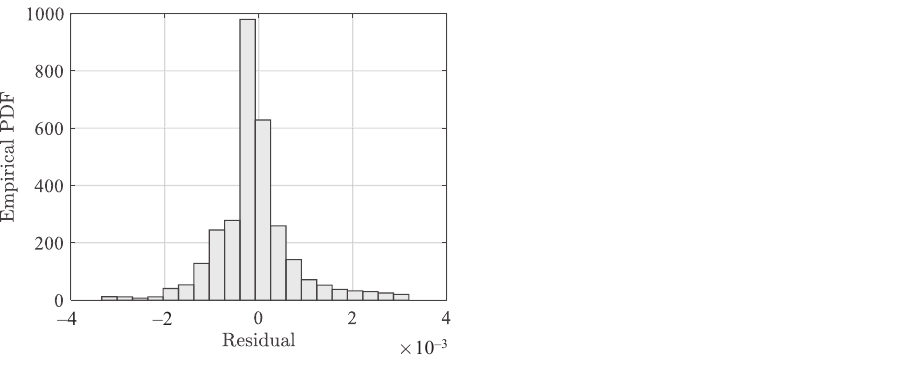
Figure 12. Histogram of residuals of the temperature-dependent stress–strain model (Equation (10)) on compression